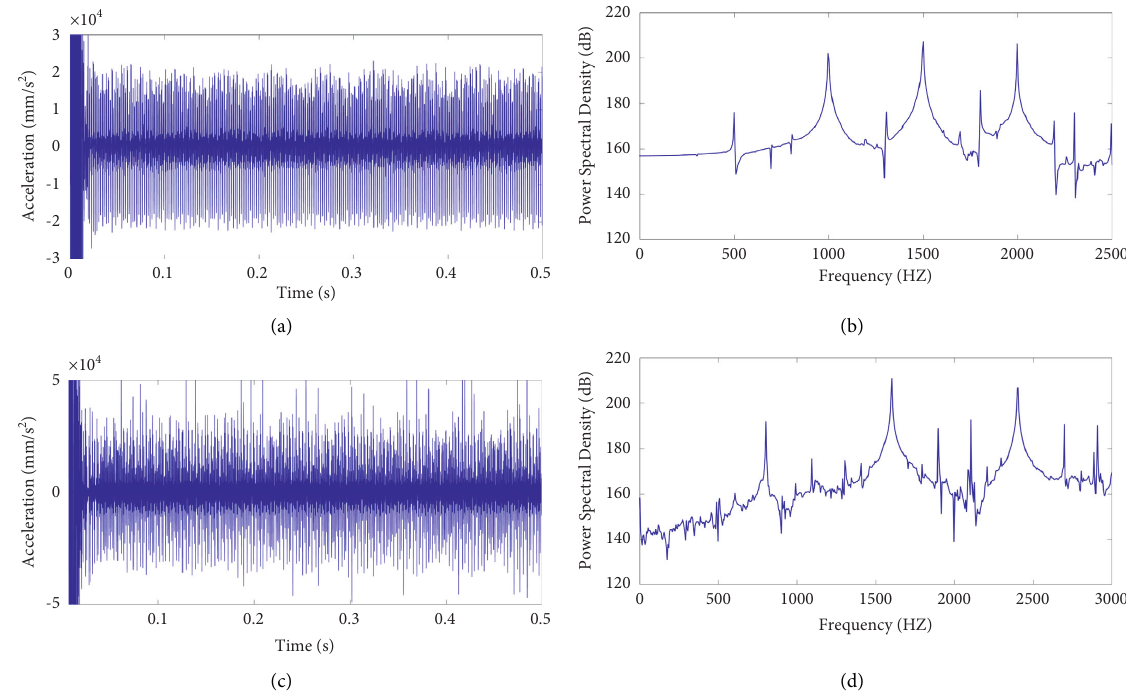
Figure 5: Diagram of vibration acceleration in the time domain and frequency domain. (a) Time domain and (b) frequency domain of the low-speed shaft gear. (c) Time domain and (d) frequency domain of the high-speed shaft gear.